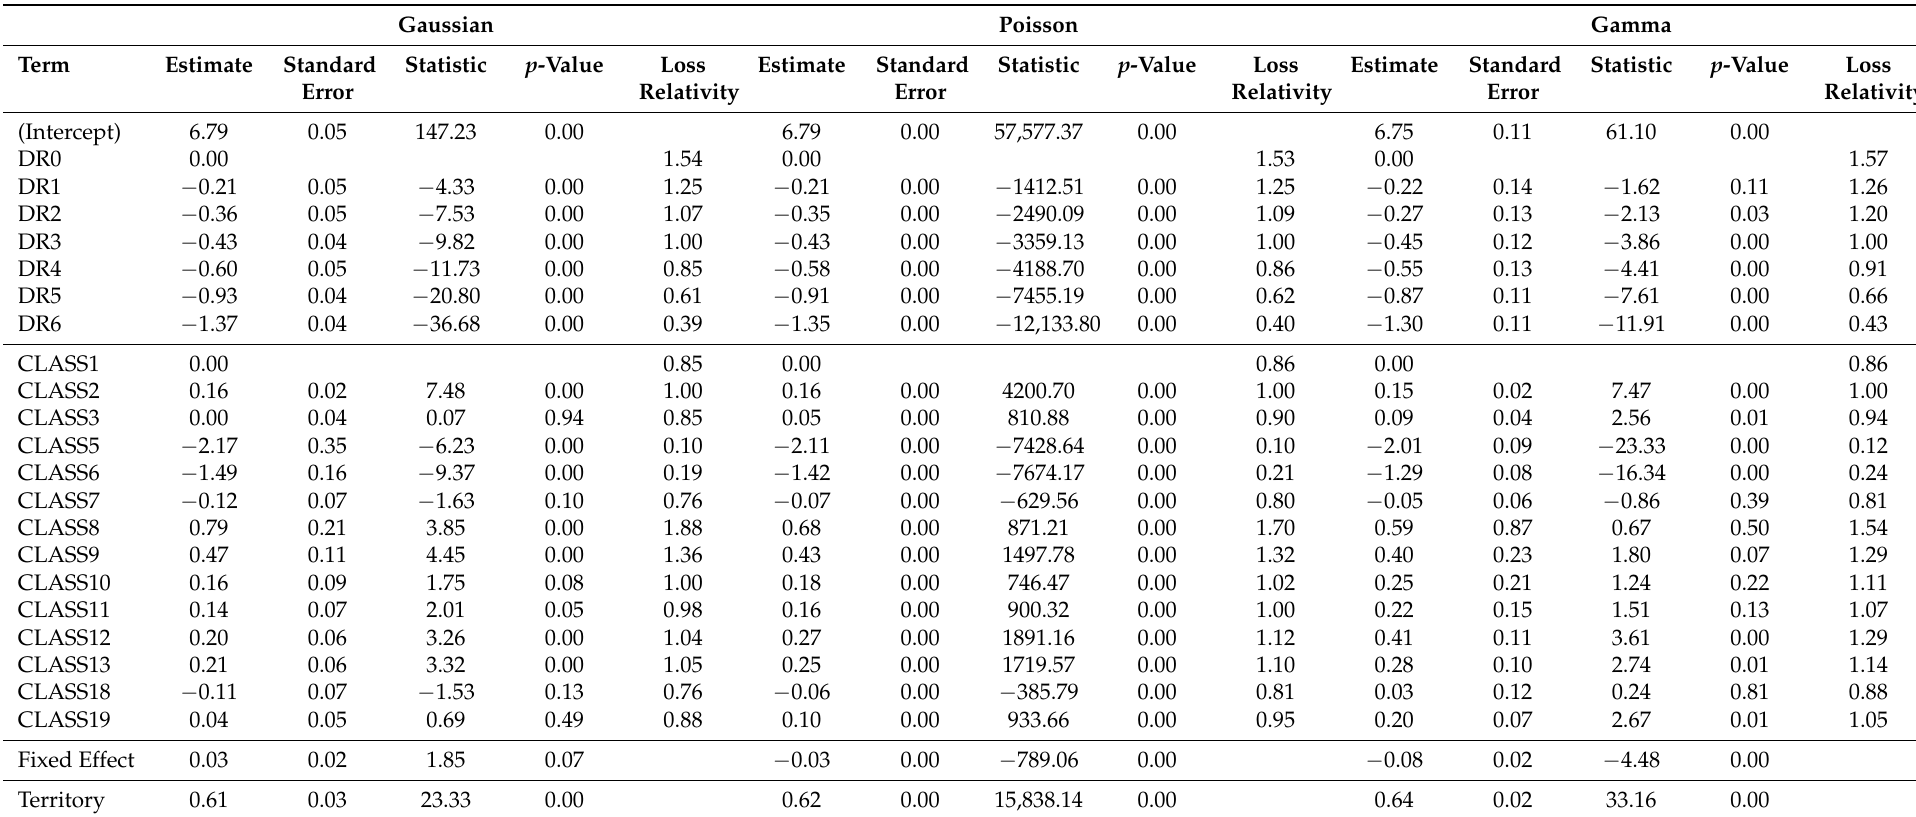
Table 3. Risk relativity estimates of DR and CLASS for AB coverage using the combined data of three accident years under the three-way model. Gaussian Poisson